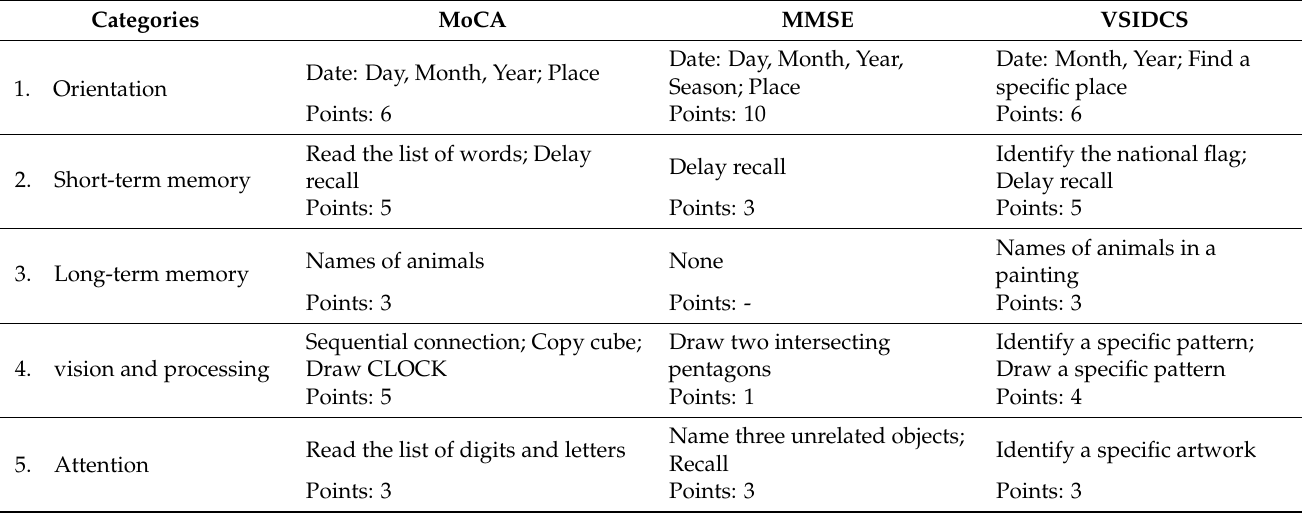
Table 2. Evaluation items, methods, and scoring of